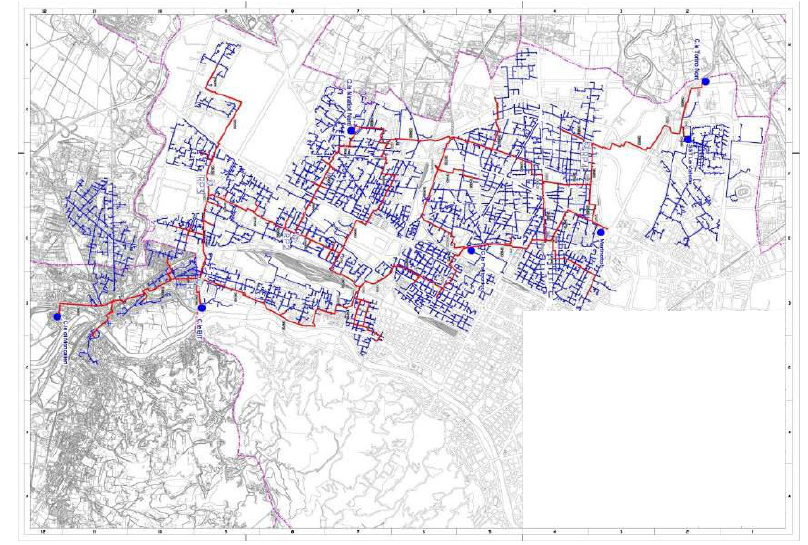
Figure 1. Turin district heating (DH) network extension. Reproduced from [27,28], IREN